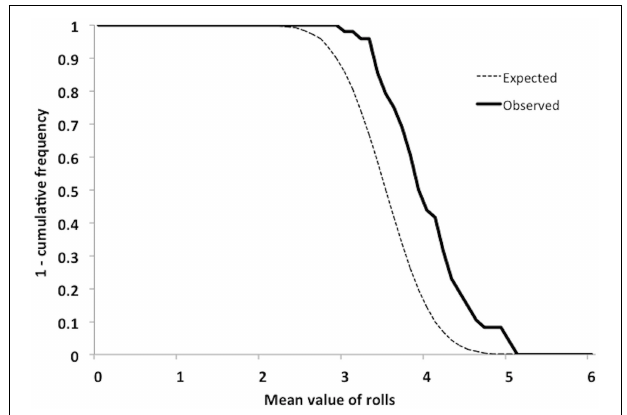
FIGURE 5 | Probability of honest reporting. Expected and observed cumulative probabilities (subtracted from one) of obtaining mean values of 0–6 for 40 die